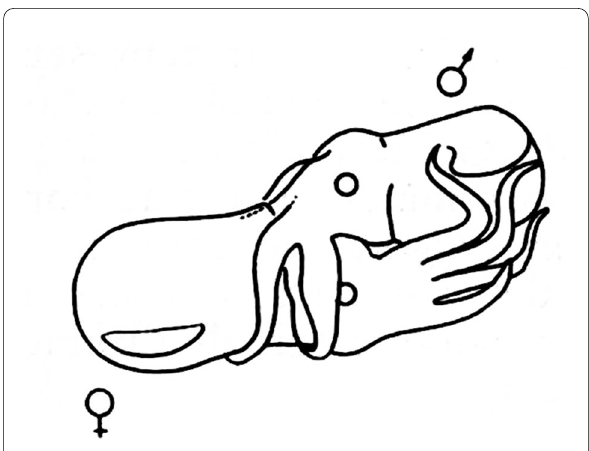
Fig. 4 Mating in the species of the genera Rossia , Sepiola and Sepietta (after Mangold-Wirz, 1963)